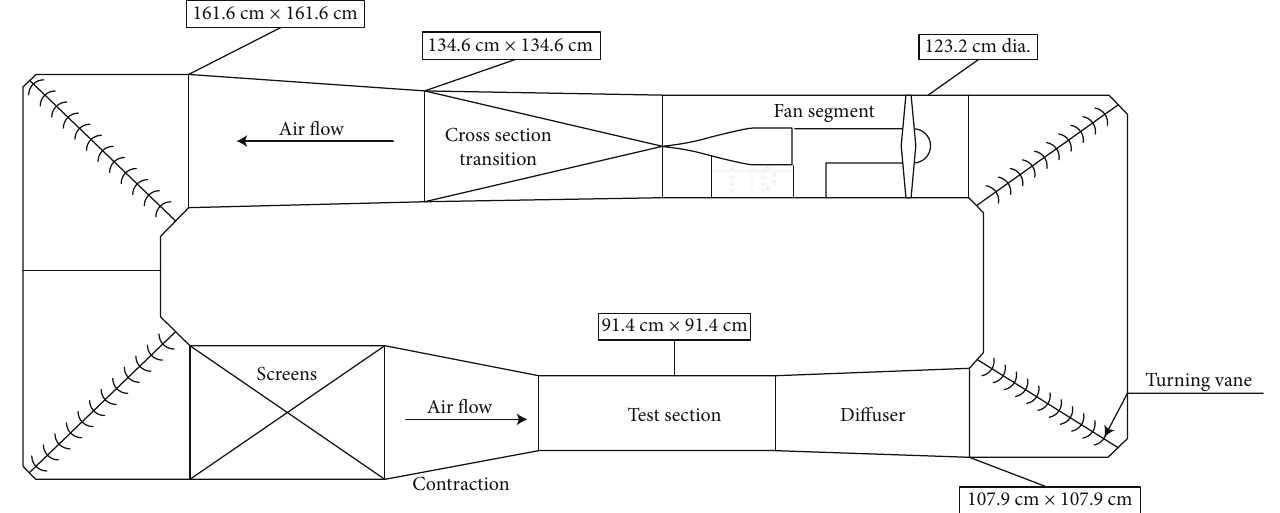
Figure 1: Layout of the Ryerson University ’ s wind tunnel.